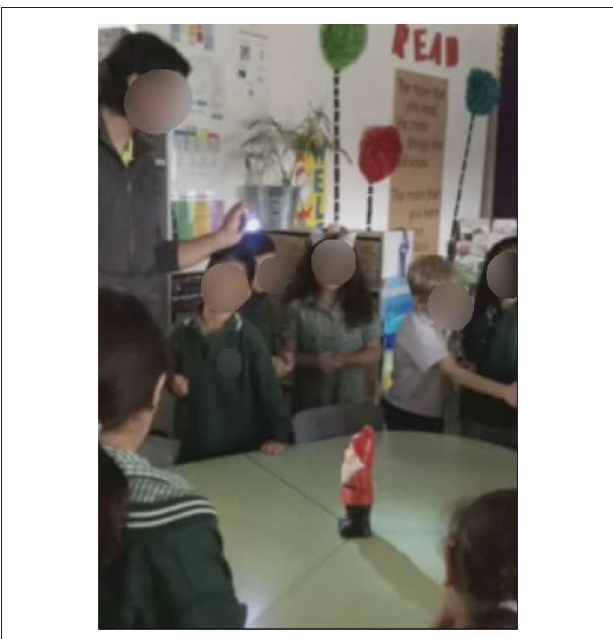
FIGURE 8 | Colin using a torch and gnome to flexibly model sun-shadow